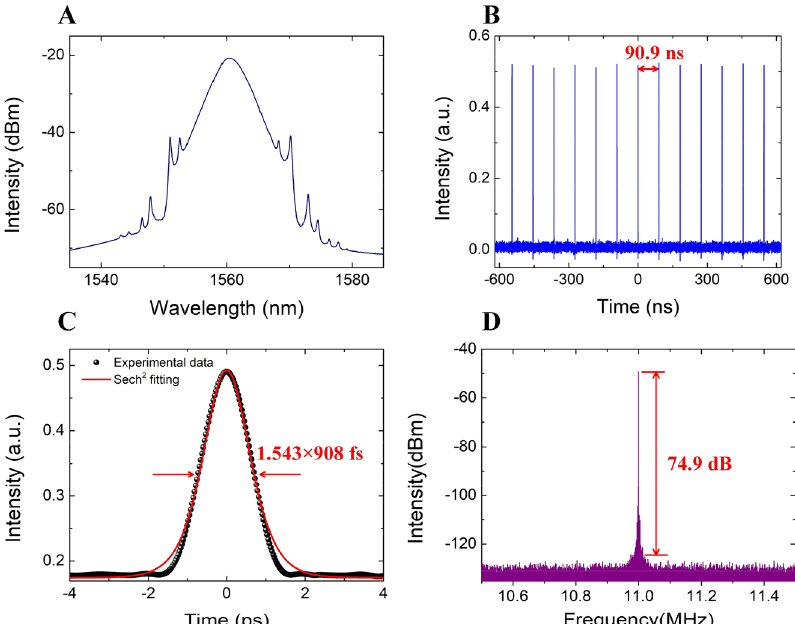
Figure 4: Mode-locked operation at 1550 nm. (A) Optical spectrum, (B) pulse trains, (C) autocorrelation trace, (D) RF spectrum.